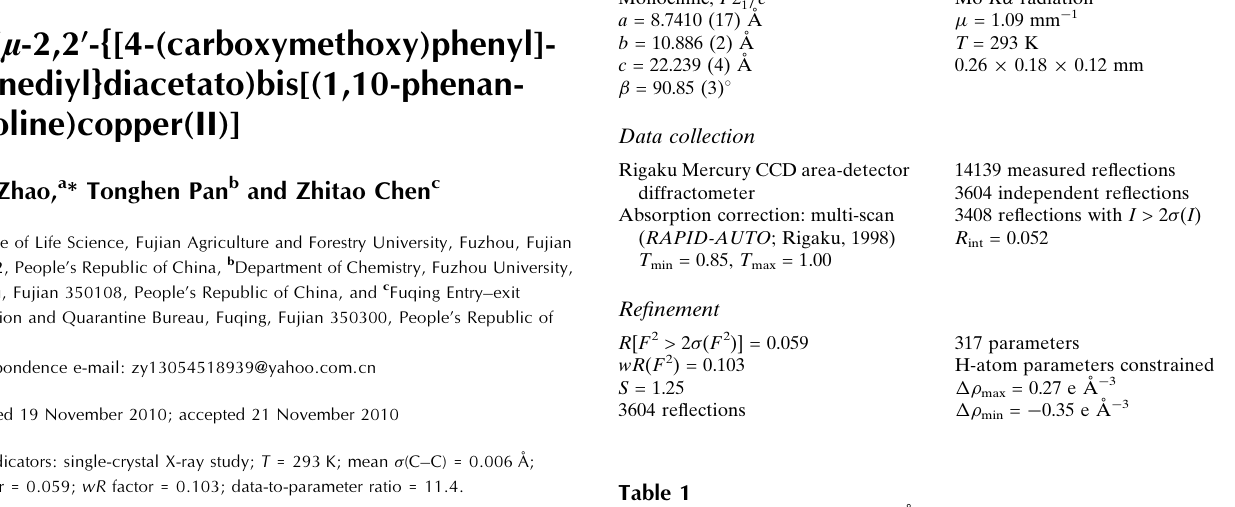
Selected geometric parameters (A˚ , (cid:3) ).